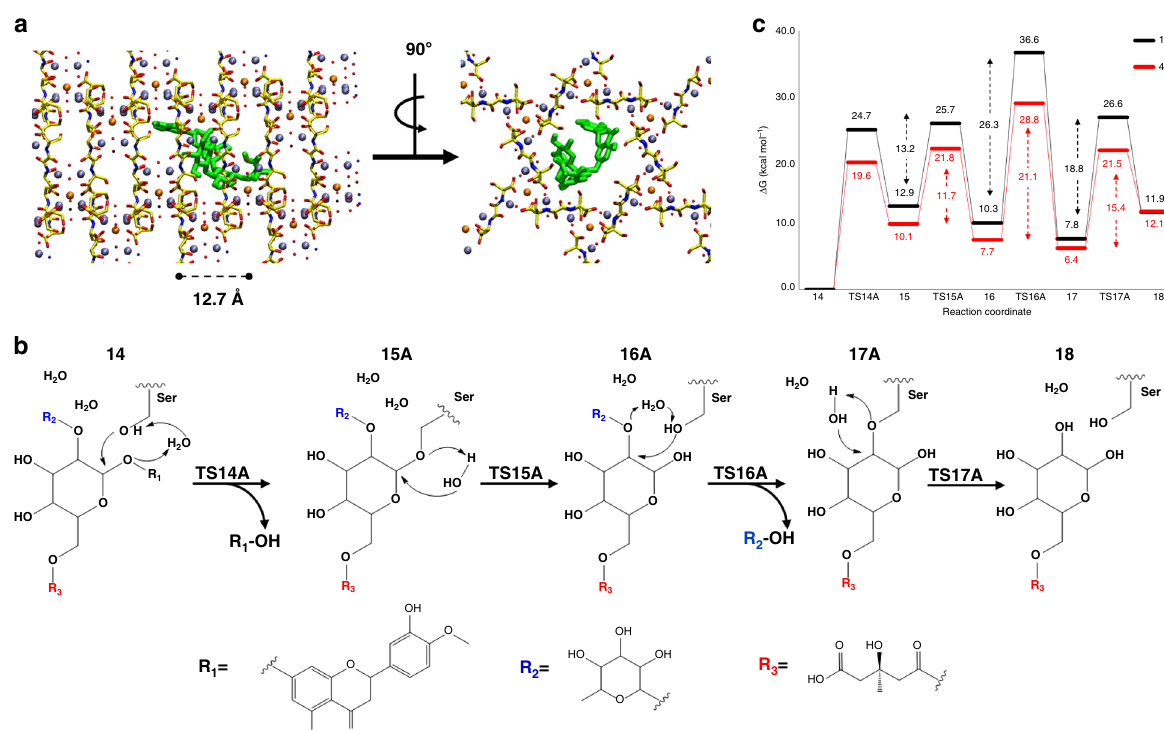
Fig. 5 Theoretical mechanism for the MOF-catalyzed glycosyl hydrolysis. a The best docked pose selected on the basis of the applied geometrical and energetic fi lters. The studied catalytic mechanisms ( b ) followed in the hydrolysis reaction of 11 by MOF 2 and related PES ( c ) calculated at B3LYP-D3/6- 311 + G(2d,2p)|UFF//B3LYP/6-31G(d)|UFF level of